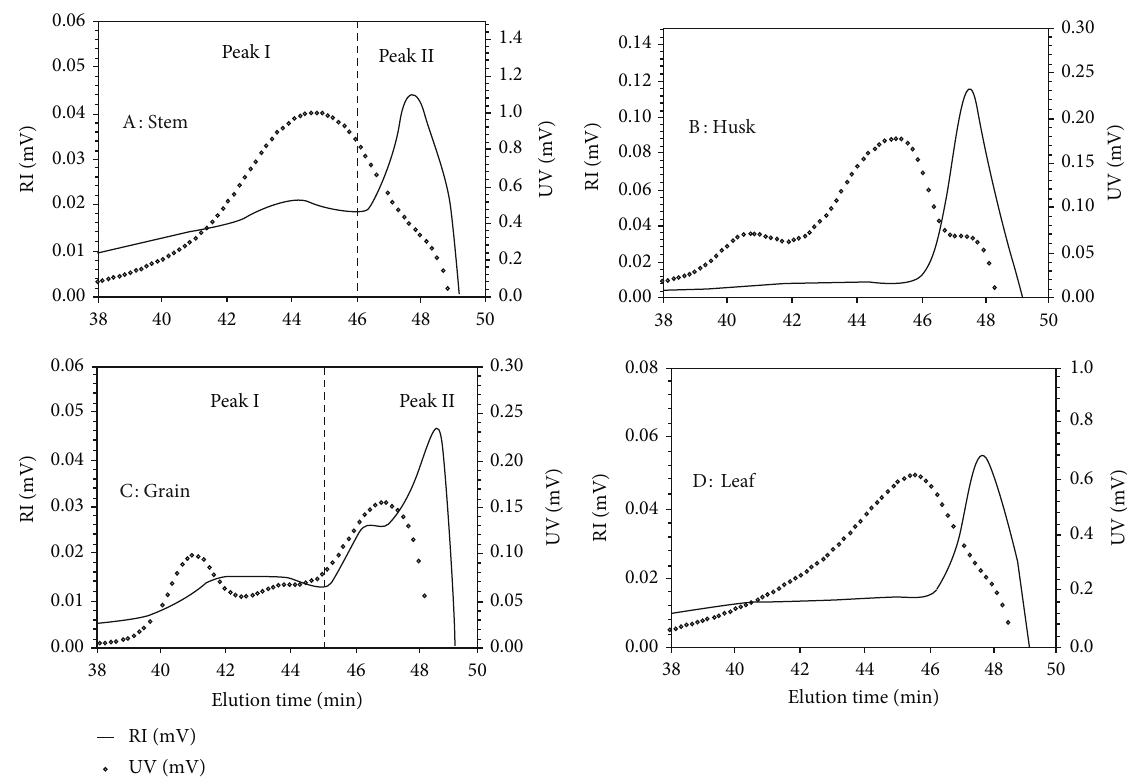
Figure 1: Refractive index and UV chromatography pro fi les of fresh rice SDF in various parts of rice. Table 2: Molecular weight ( M ) and radius of gyration ( R w fresh rice